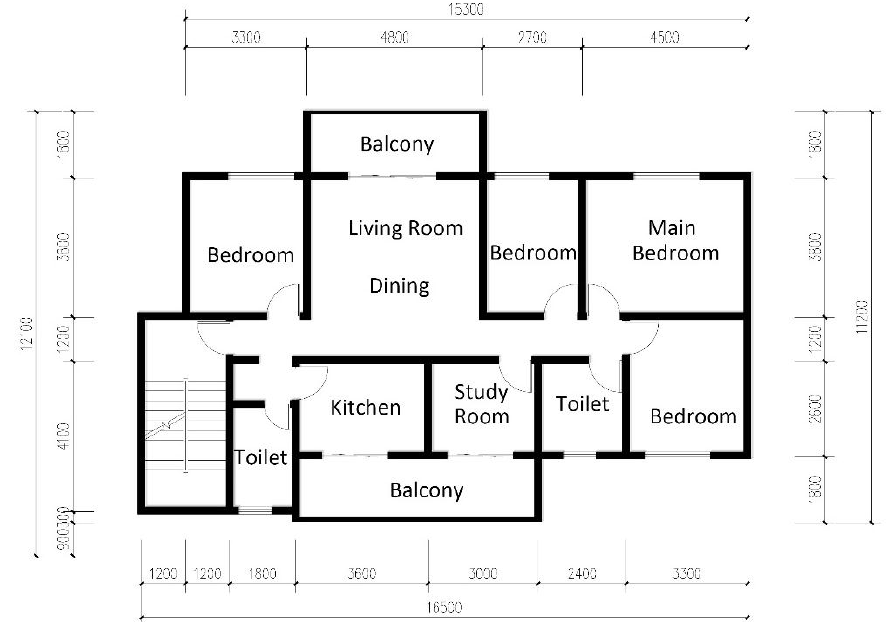
Figure 3. The plan of the apartment before